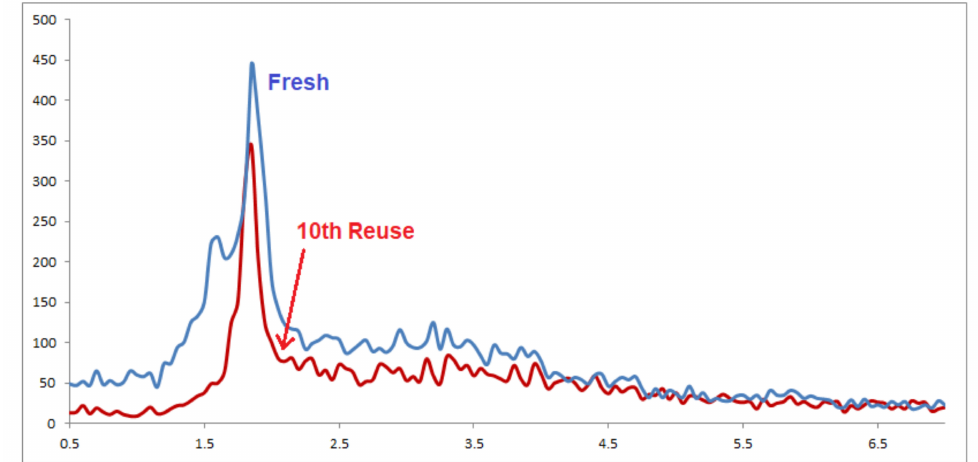
Figure 2. XRD pattern of fresh and recycled Pd-Cyt@SBA-15